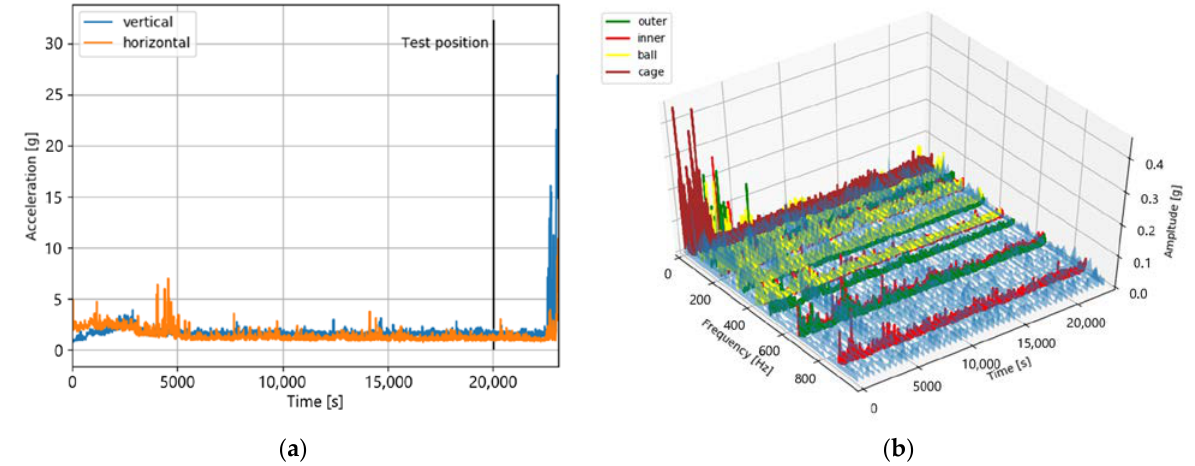
Figure 13. The sensor values of bearing dataset 2_5 in the time domain ( a ) and the time–frequency domain ( b ). Both plots do not indicate a degradation at the test position.